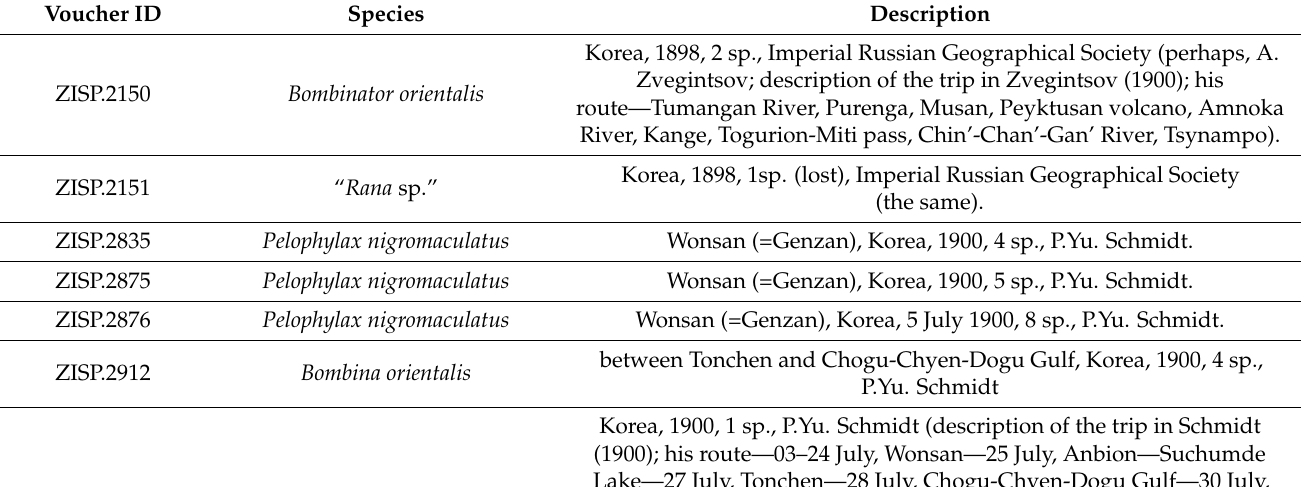
Table 1. Amphibian collection at the Zoological Institute of the Russian Academy of Sciences, St. Petersburg, Russia, and the Zoological Museum of Moscow State University, Moscow, Russia, originating from DPR Korea and collected by the Chosun Academy of Science (DPR Korea Academy of Sciences). These datapoints are not reported later in the text in case of overlap with known combinations of species and